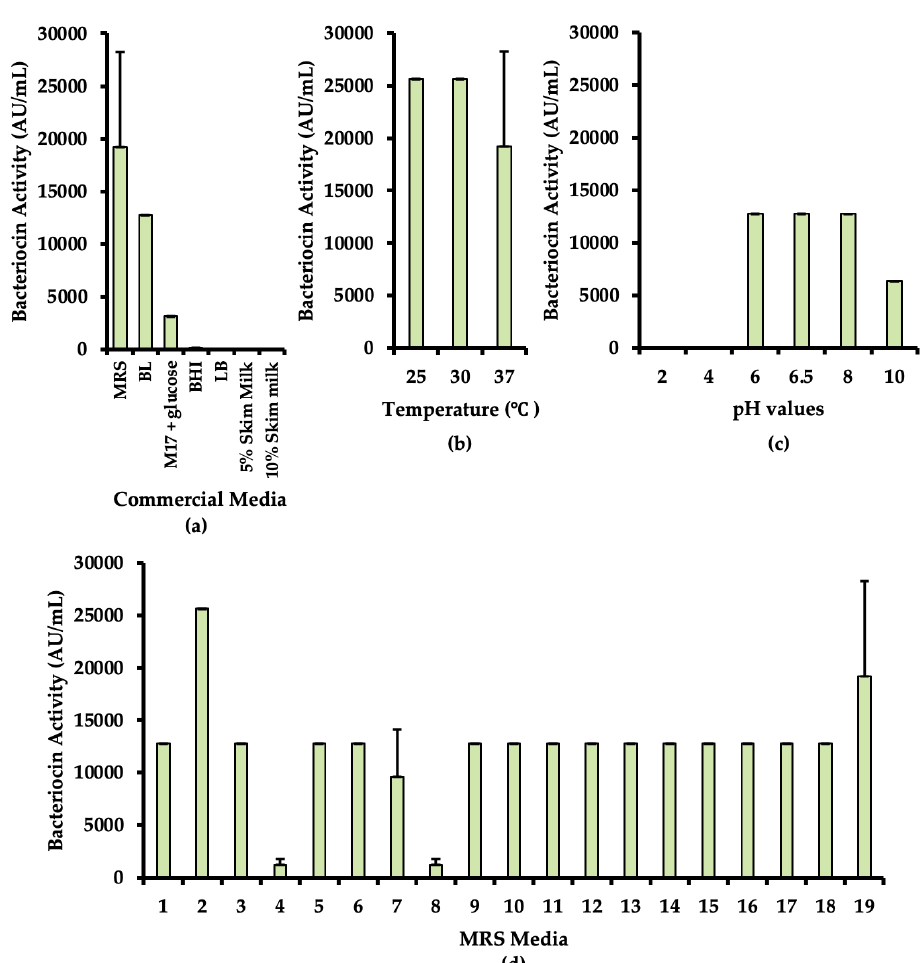
Figure 2. Optimization of medium and environmental conditions for bacteriocin production of E. faecium ST10Bz evaluated against L. monocytogenes ATCC ® 15313™ as indicator strain. ( a ) With different commercial media, ( b ) at different temperatures, ( c ) different pH-values, and ( d ) different modifications of MRS medium (for information on medium composition see Table S1). In experiments where no differences in levels of bacteriocin production were observed, standard deviation values were not presented.